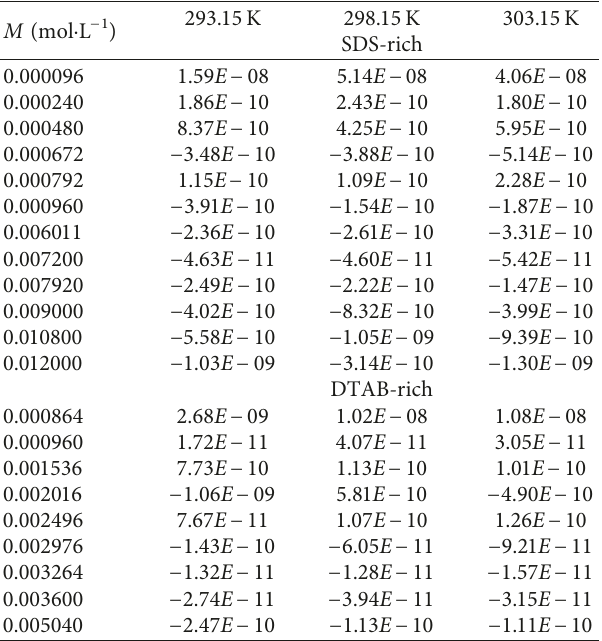
Table 6: Area of the molecule ( A DTAB-rich surfactants in the aqueous medium at the three dif- ferent temperatures T � 293.15, 298.15, and 303.15K and at